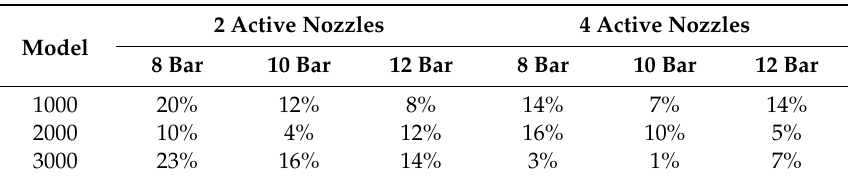
Table 4. Relative error (%) of the mean fluid velocities estimated experimentally and by CFD, separated by calculation